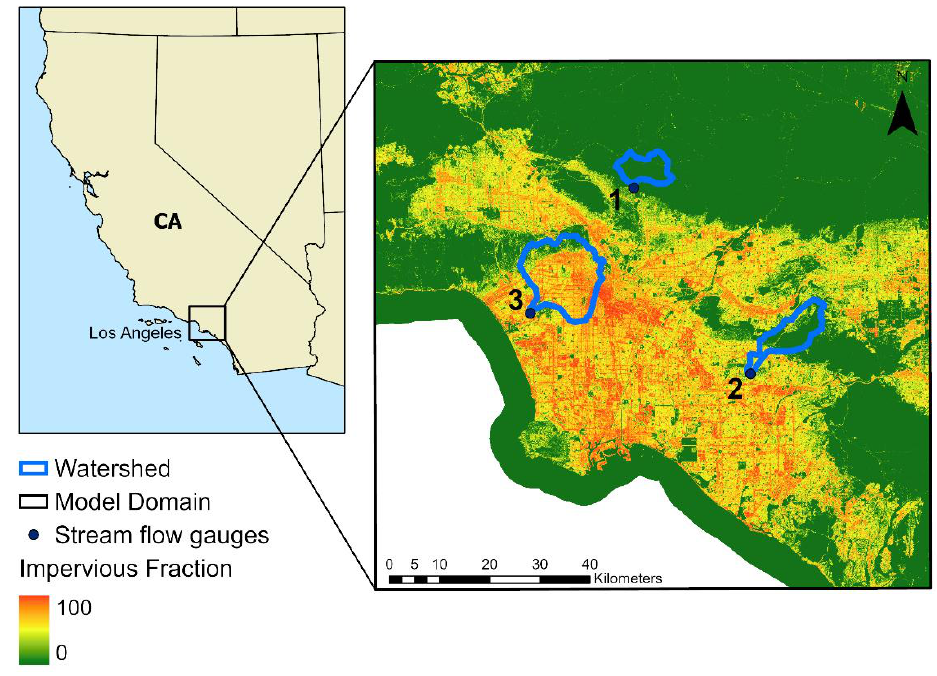
Figure 1. WRF – Hydro modeling domain in the LA Metropolitan area. The coverage of impervious surfaces is shown for the (1) Arroyo Seco, (2) Brea Creek, and (3) Ballona Creek watersheds.